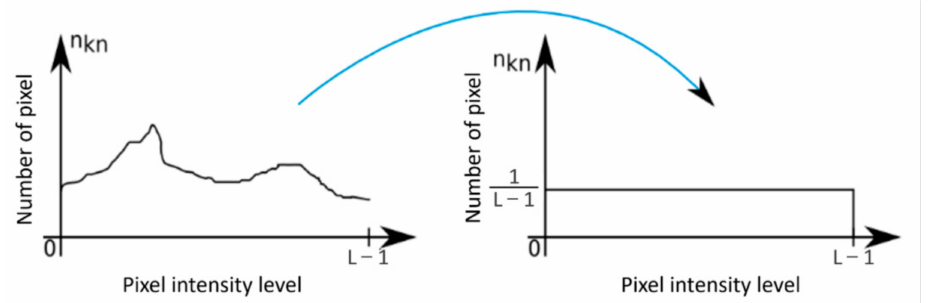
Figure 7. The histogram equalization